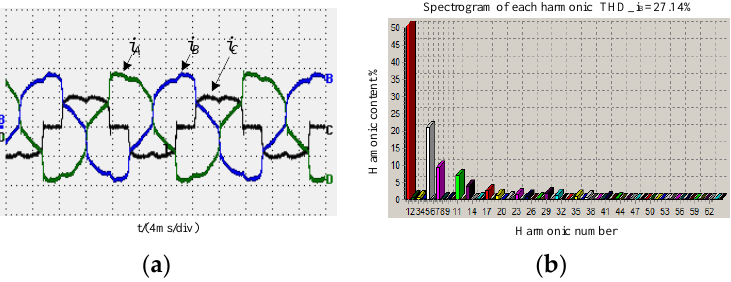
Figure 24. Uncompensated waveforms: ( a ) current of power grid; ( b ) THD of B-phase current.